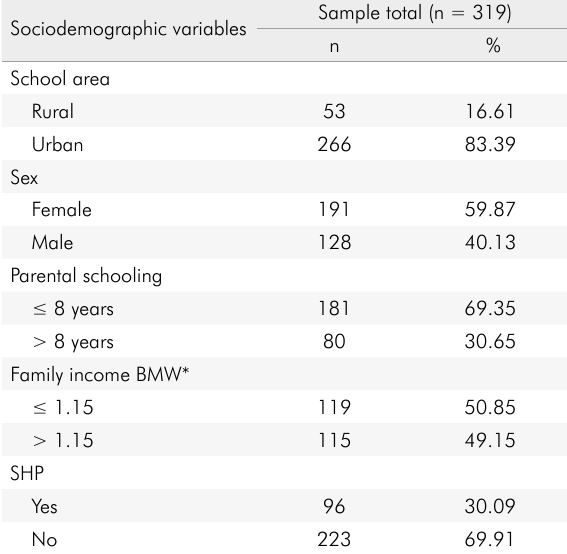
Table 1. Socio-demographic characteristics and access to SHP of the total sample of 12-year-old schoolchildren from Nova Friburgo, RJ, Brazil,